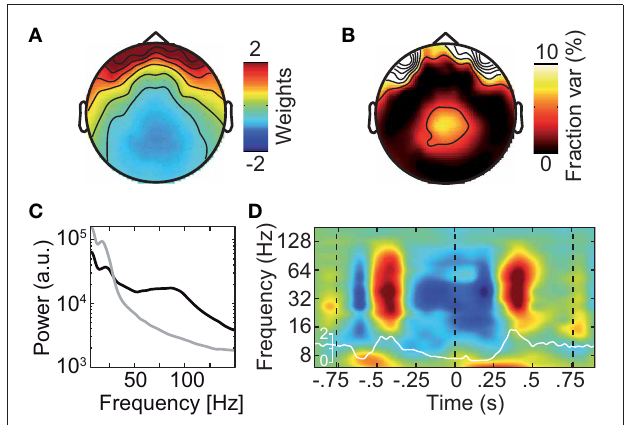
FIGURE 6 | Exemplary independent component (IC) that captures the saccadic spike artifact. (A) Scalp topography of the saccadic spike IC. (B) Scalp topography of the fraction of signal power explained by the saccadic spike IC. (C) Power spectrum of the saccadic spike IC (black) and average power spectrum of all physiological (i.e., non-muscle) ICs (gray). (D) Change in the saccadic spike ICs’ signal power relative to prestimulus baseline resolved in time and frequency. The white line shows the concurrent microsaccade rate for comparison (compare Figure 5A ).